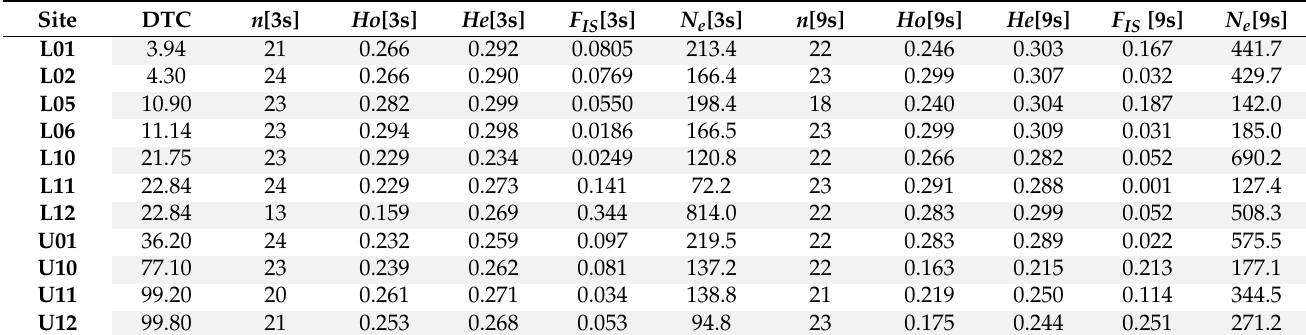
Table 1. Overview of population genomics statistics per site for populations of three-spined ([3s]) and nine-spined ([9s]) stickleback. DTC: distance to the coast in kilometers, n : number of individuals per population retained for downstream analyses, Ho : observed heterozygosity, He : expected heterozygosity, F IS : inbreeding coefficient. N e : effective population